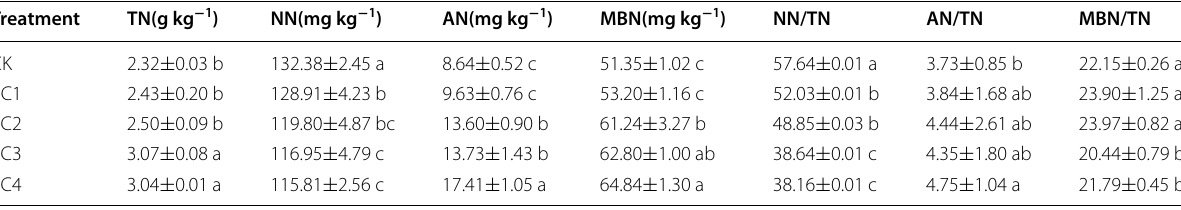
Values are presented as mean SD ( n 4), and data with different lowercase letters are significantly different at p < 0.05 according to Duncan’s multiple range test ± = Abbreviations : TN total inorganic N, NN nitrate nitrogen, AN ammonium nitrogen, MBN microbial biomass of